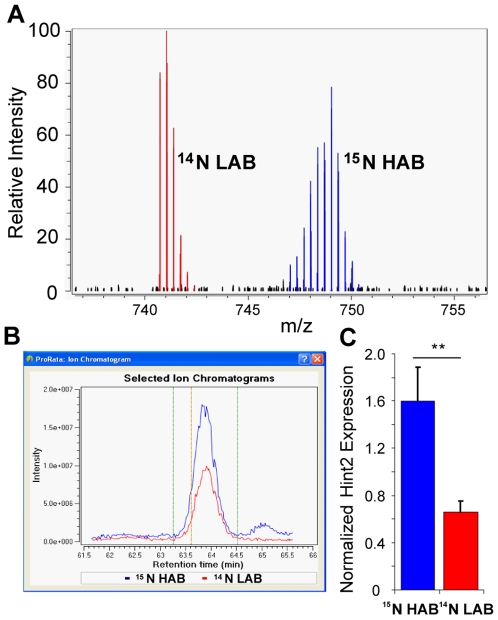
Analysis of expression differences by MS analysis and RT-PCR.
A) ESI mass spectrum of the 14N LAB (red) and 15N HAB (blue) isotope forms of the Hint2 peptide ISQAEEDDQQLLGHLLLVAK in cerebellar tissue. The isotopologue patterns of the 14N and 15N peptide signals (m/z) were used for relative quantification with ProRata. B) Extracted ion chromatograms for the Hint2 peptide, extracted from A, showing an upregulation of Hint2 in HAB mice. C) Analysis of Hint2 transcripts in 15N-labeled HAB and 14N LAB cerebellar cDNA by RT-PCR, normalized by HRSP12 expression. Hint2 expression in HABs was 2.5-fold higher compared to LABs (*p<0.05). No smoothing was applied.